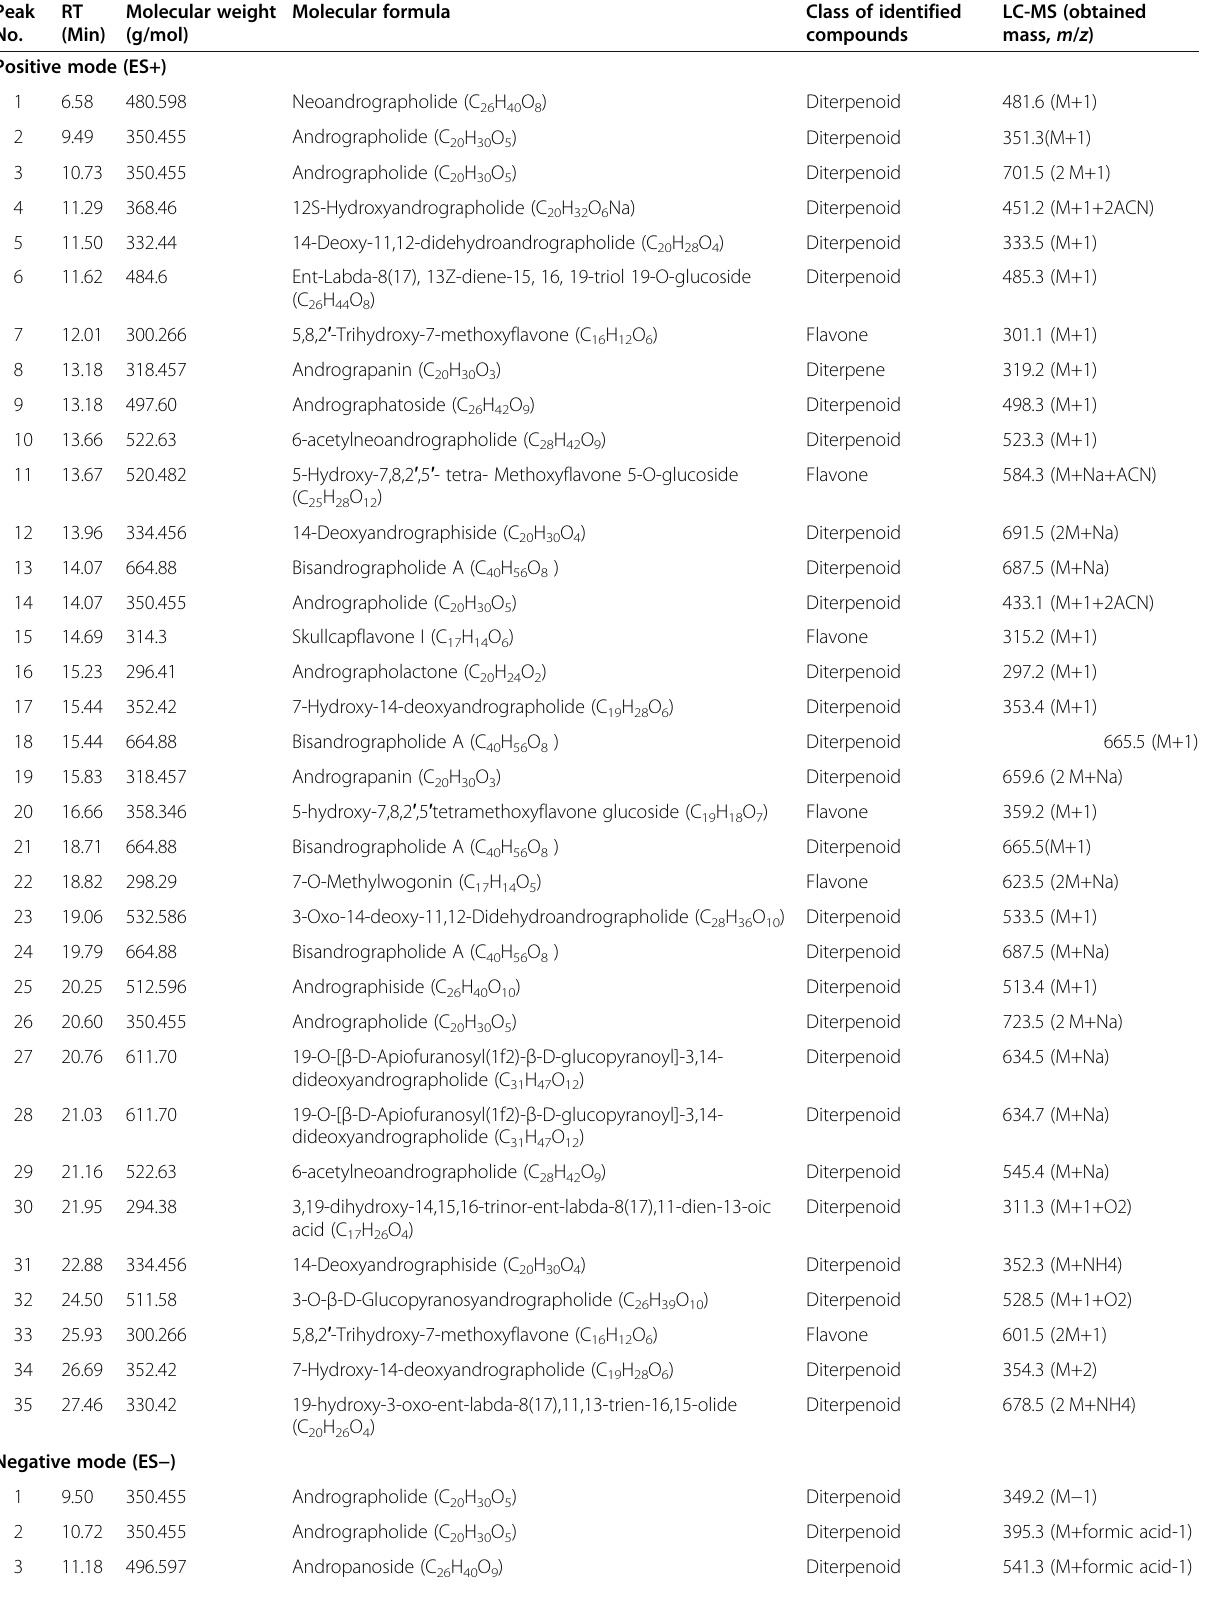
Table 3 Identification of compounds present in anti-malarial active extract of Andrographis paniculata by LC-MS/MS analysis Peak